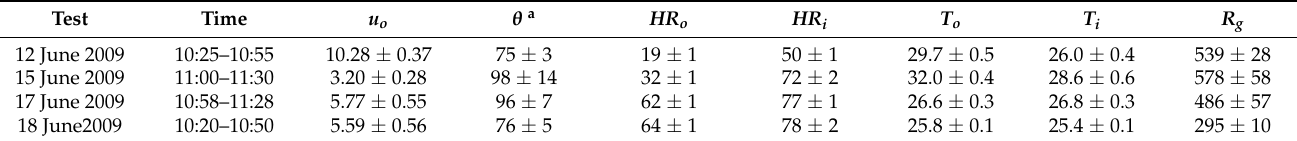
Table 2. Climatic conditions from the experimental tests (inside and outside the greenhouse):